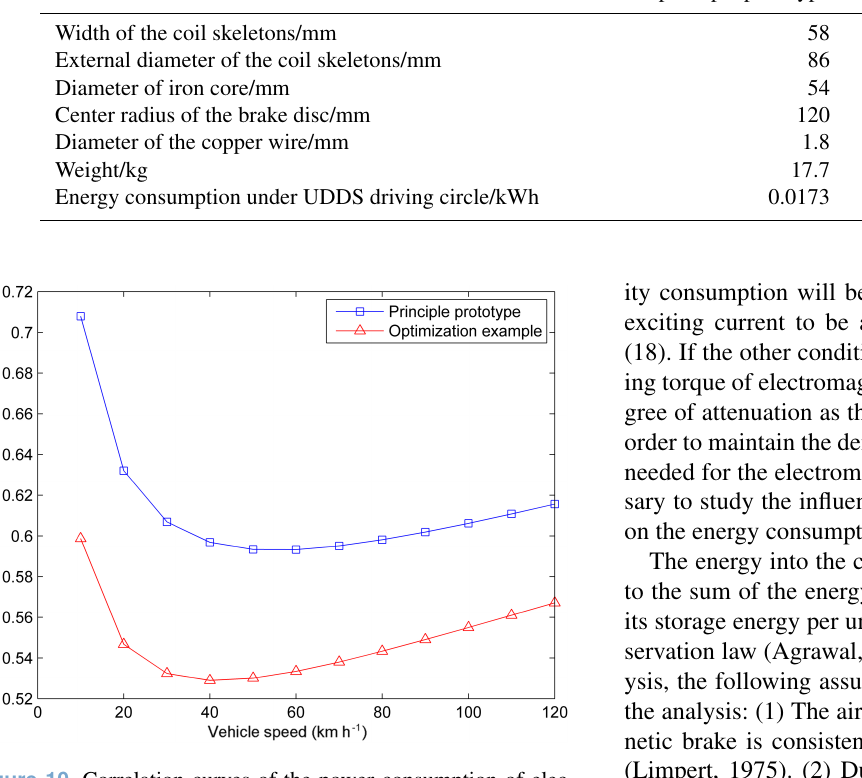
Figure 10. Correlation curves of the power consumption of elec- tricity before and after the optimization design.